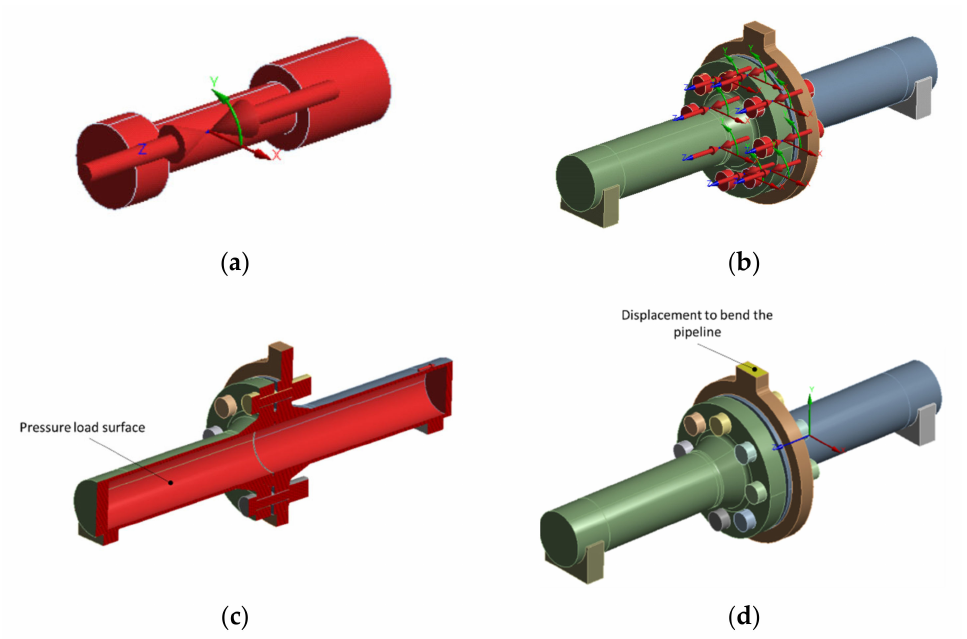
Figure 12. Flange joint load: ( a ) view of a bolt with a marked vector of the bolt-shortening direc- tion; ( b ) view of the bolt assembly in the flanged joint; ( c ) joint load surface with 2 MPa pressure; ( d ) defining the displacement vector towards which the pipeline fragment was bent.